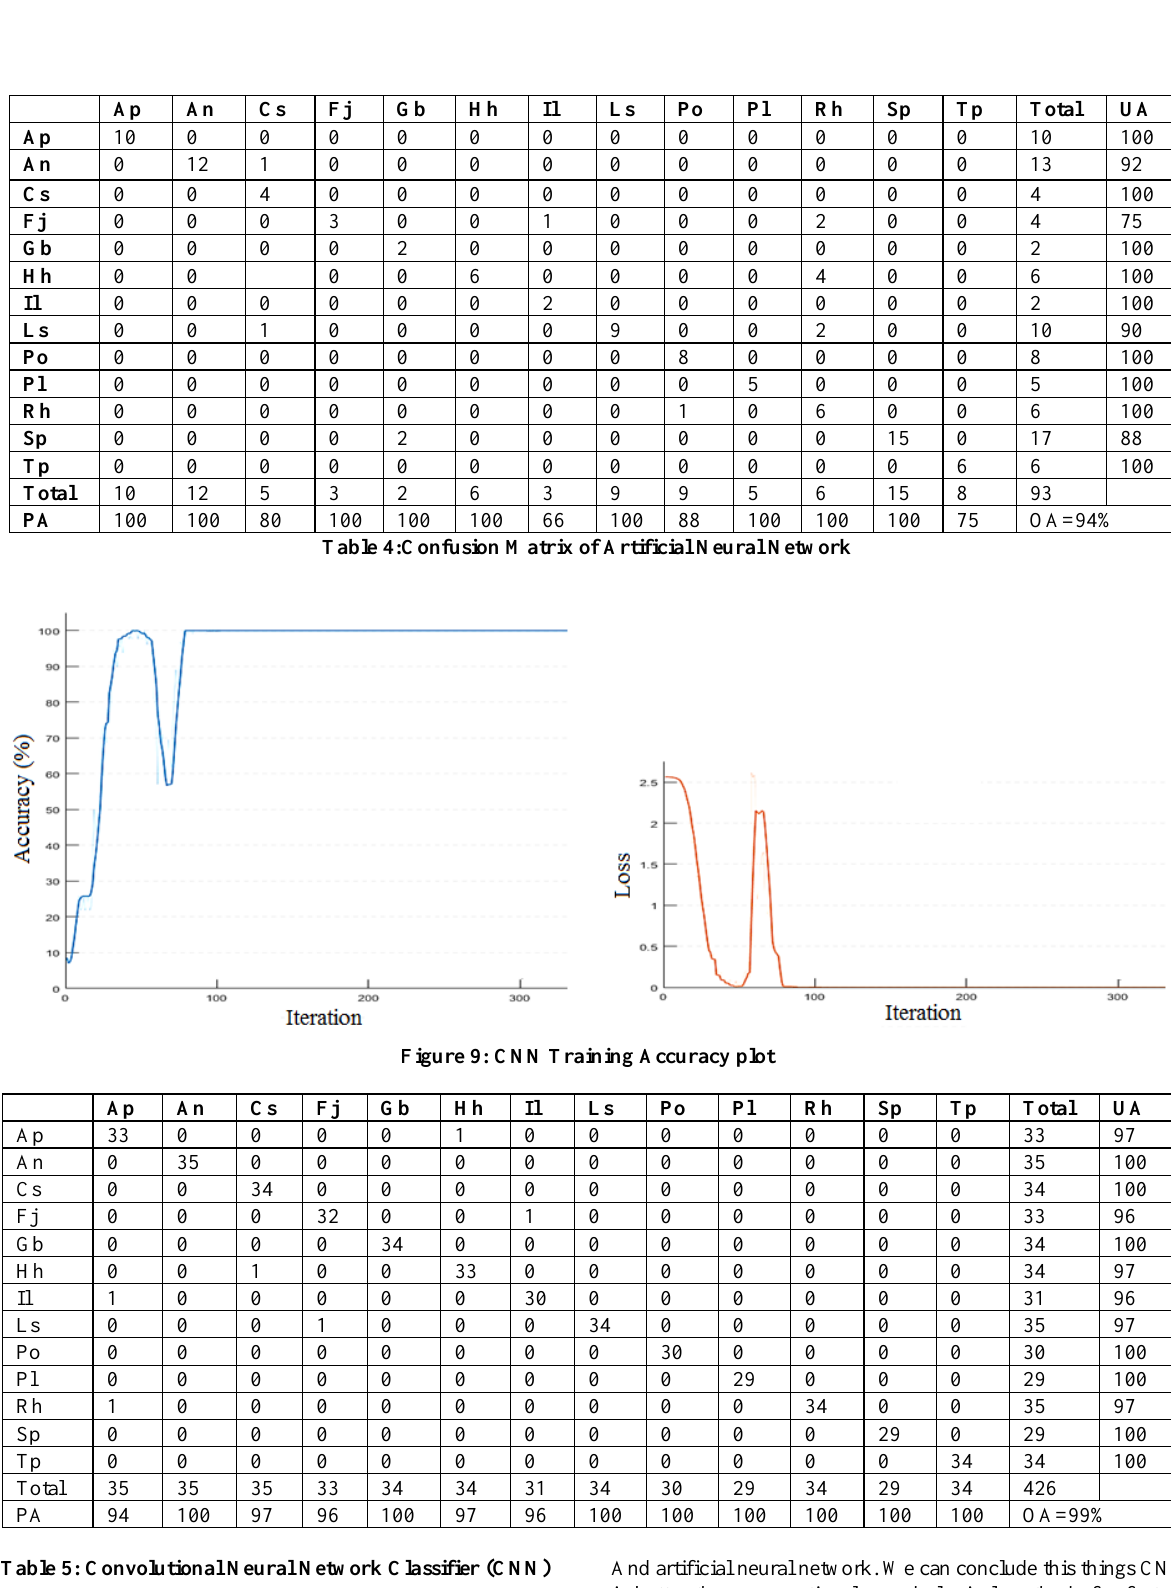
Table 5: Convolutional Neural Network Classifier